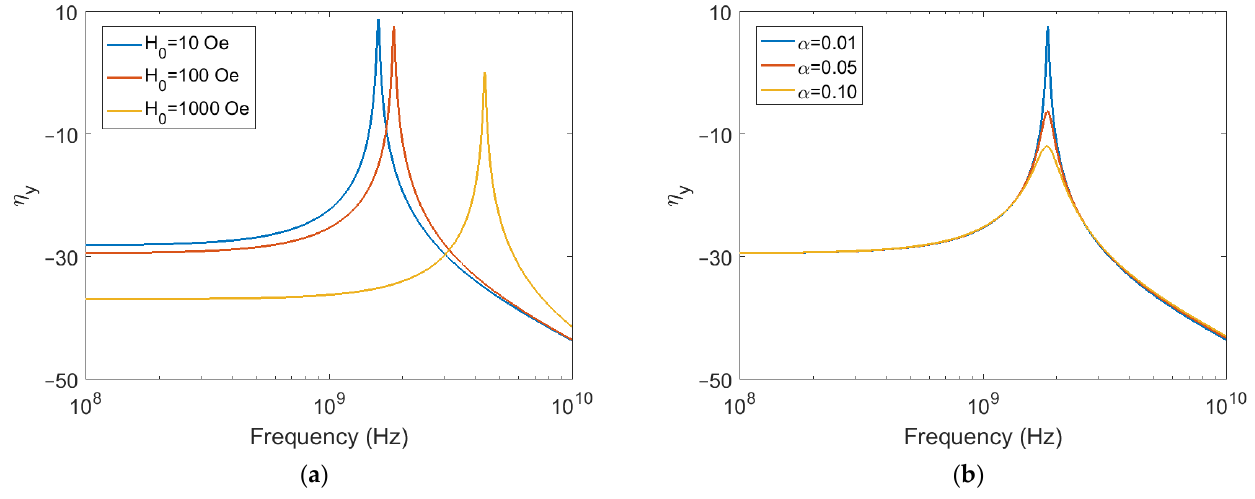
Figure 2. Magnetoelastic coupling coefficient magnitude for 𝜙 = 45° . ( a ) Varying magnetic biasing; ( b ) Varying magnetic damping. ( b ) Varying magnetic